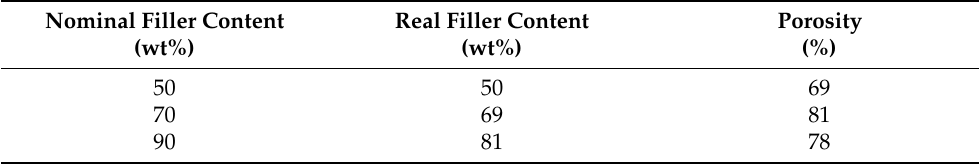
Table 3. Porosity of porous samples (iii, iv) at different filler content.